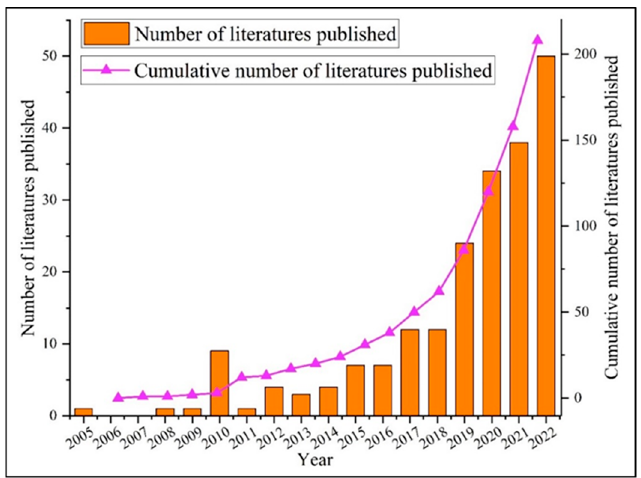
Figure 2. Annual publication and cumulative publication of documents (2005–2022).